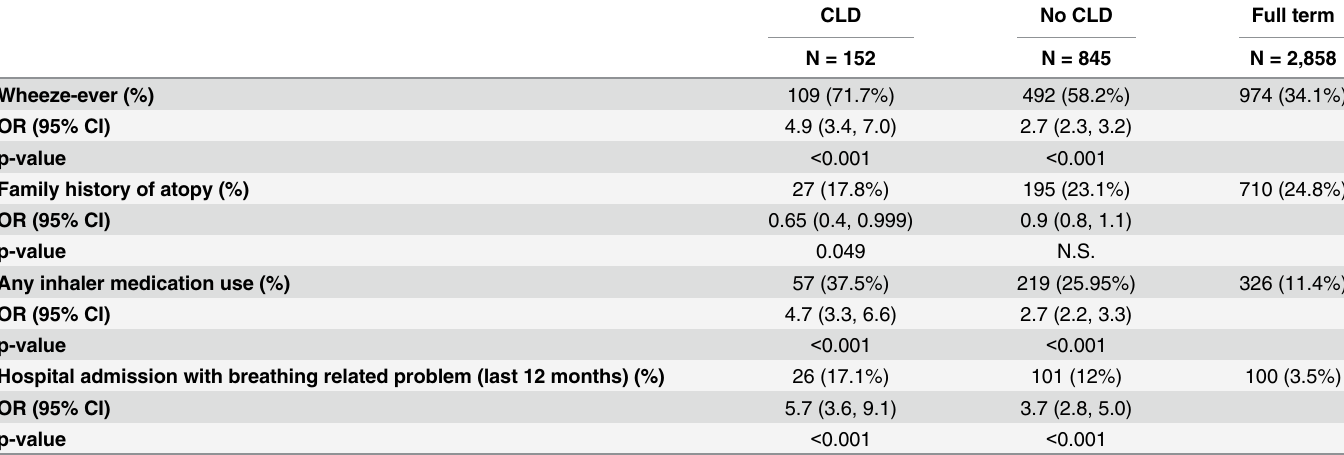
Table 6. Childhood wheezing, family history, inhaler use and hospital admissions for very preterm born children with or without CLD compared to full term (unadjusted